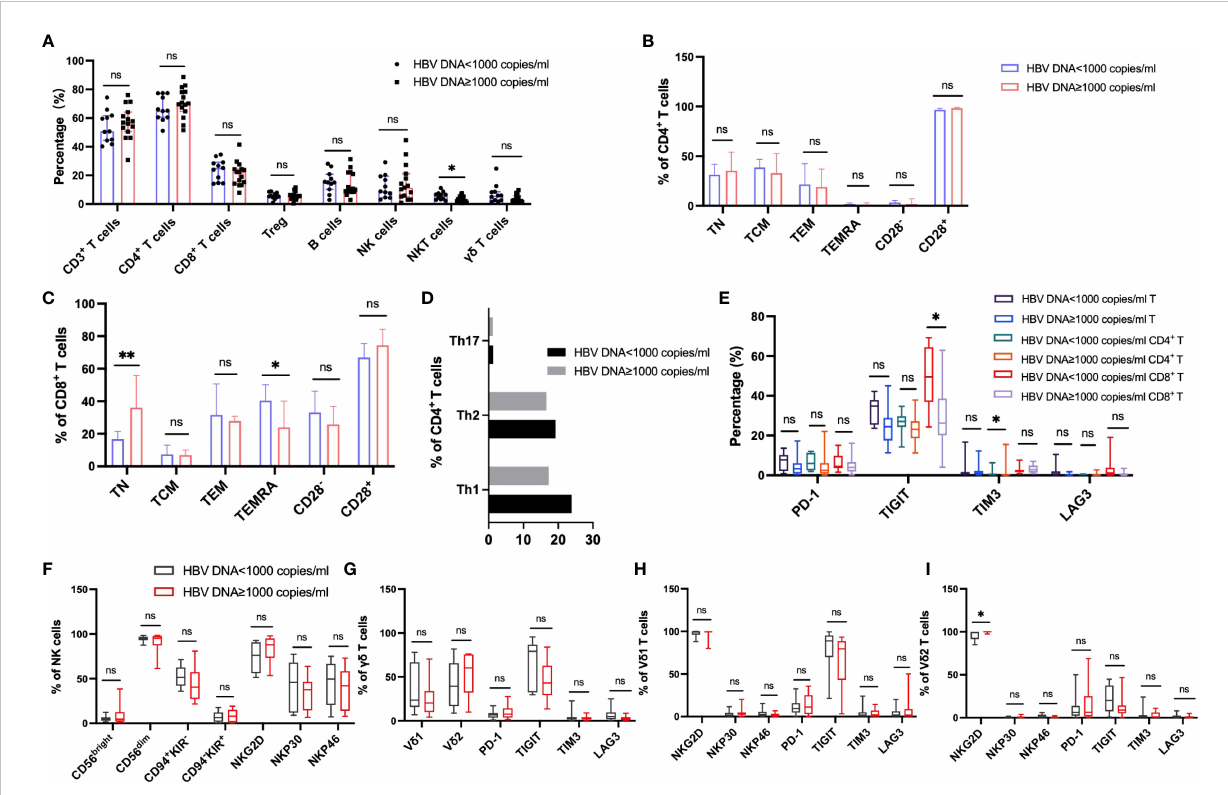
FIGURE 7 Circulating lymphocytes and their immunophenotypic characteristics in the patients with HBV DNA<1000 copies/ml and patients with HBV DNA ≥ 1000 copies/ml. (A) The frequencies of ab T, B, NK, NKT and gd T cells in the two groups. (B, C) The expression of CD28, CD45RA and CCR7 on the surface of CD4 + T cells and CD8 + T cells in the two groups. (D) The frequency of CD4 + T cell subsets in the two groups. (E) Differences in the expression of inhibitory receptors on the surface of peripheral blood CD3 + T cells, CD4 + T cells, and CD8 + T cells between the two groups. (F) The expression of cytotoxic and activating receptors of circulating NK cells in two groups. (G – I) Differences in the expression of activated receptors and inhibitory receptors on the surface of gd T cells and its subsets V d 1 and V d 2 cells between the two groups. T test or Mann-Whitney U test was used to determine statistical differences between the two groups. * p <0.05, ** p <0.01. ns, not signi fi